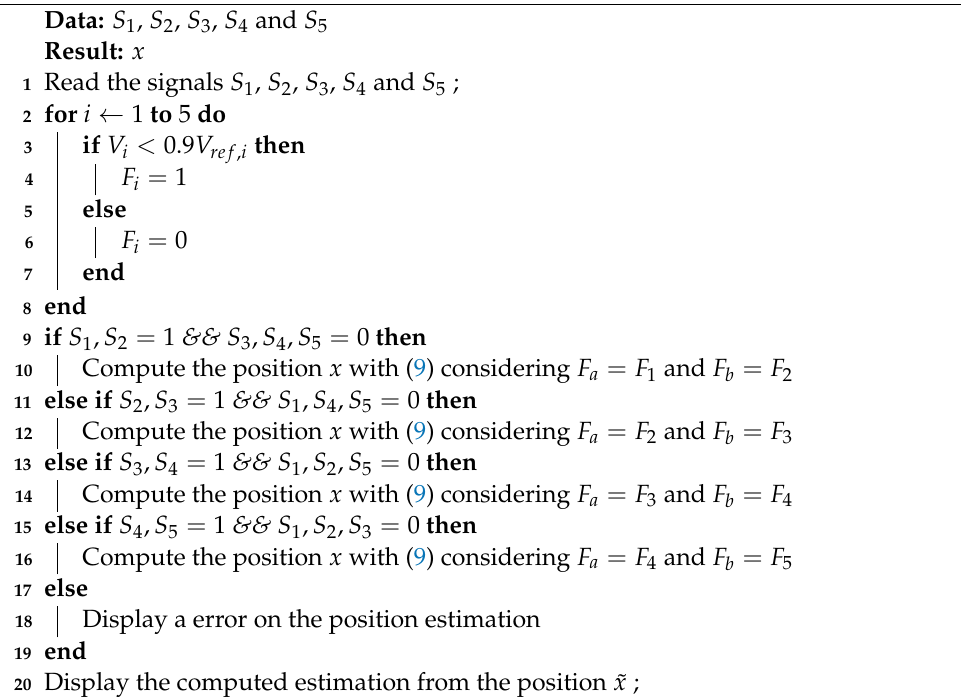
Algorithm 1: Position estimation the shaft from a linear actuator using a mag- netic sensor